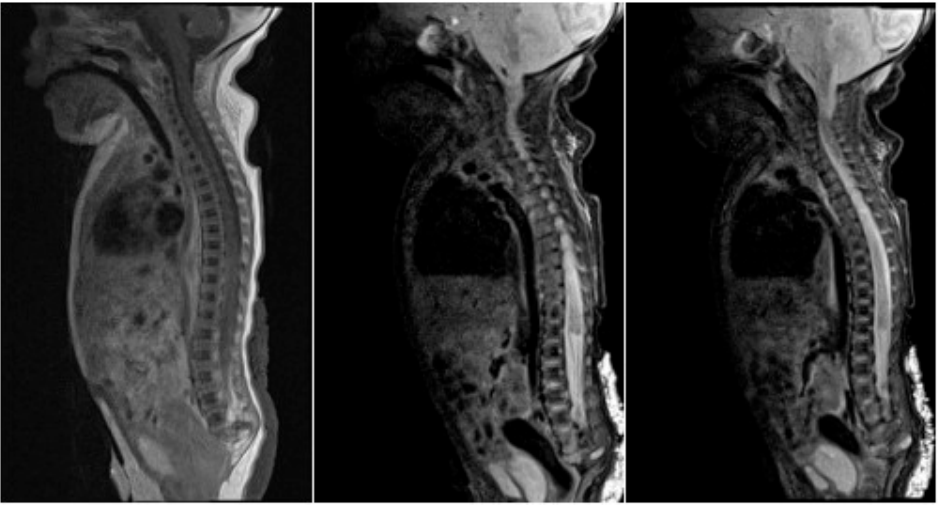
Figure 4. Sagittal MR images show vertebrae down to roughly L5 with no developed sacral elements. The conus medullaris is high at T11, with a truncated, inferior tip.